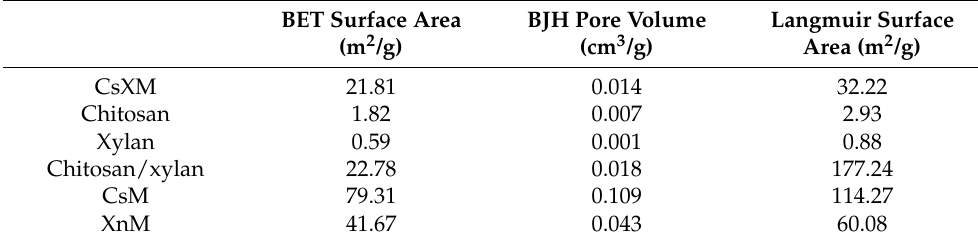
Table 1. Parameters of BET nitrogen adsorption-desorption